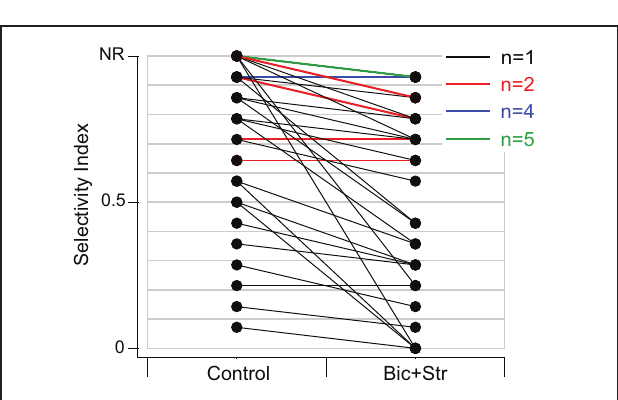
FIGURE 4 | Blocking GABA A R and GlyR significantly decreased selectivity to vocalizations in the IC of awake mice. SI values in control and drug condition for each neuron. Black lines represent one single unit, red lines represent two single units with the same values, blue lines represent four units with the same values, and green lines represent five units with the same values. Neurons in the NR (no-response) category did not respond to any vocalizations in the control condition but did respond to at least one vocalization in the drug condition. Thirty-one of forty neurons had decreased SI